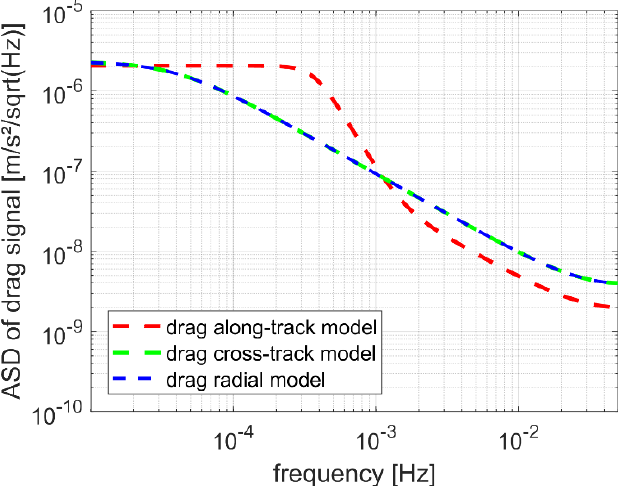
Figure 14. Drag signal model at a 361 km altitude, extrapolated from [71].